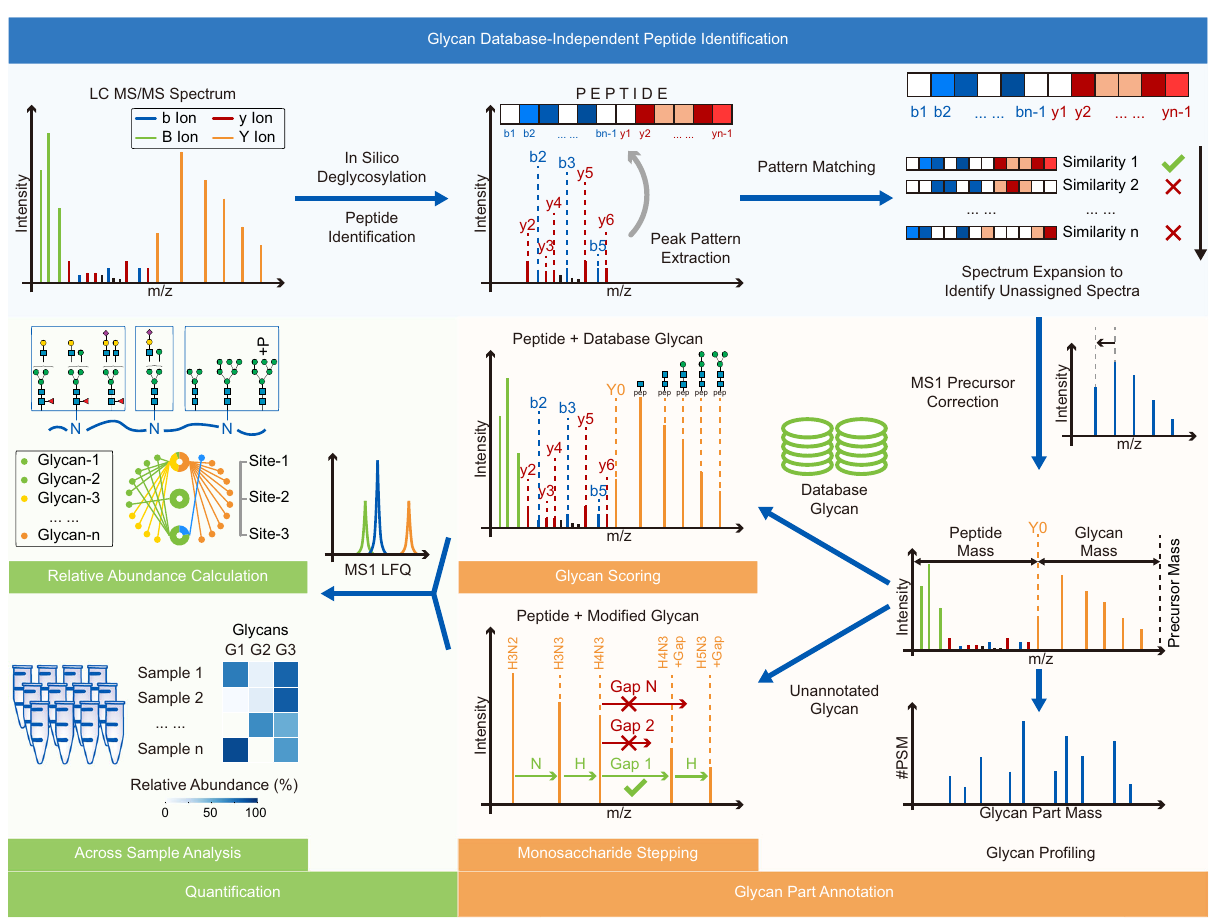
Fig. 1 Work fl ow of Glyco-Decipher. Glyco-Decipher contains three modules: (1) Glycan database-independent peptide matching. The in silico deglycosylated spectra are searched against the protein database without setting any glycans as modi fi cations, which determines the peptide backbone for glycopeptide spectra with rich peptide fragment ions. Then, the fragmentation patterns of the peptide backbones are extracted and utilized to match spectra that remain unannotated. This step, termed “ spectrum expansion ” , enables the identi fi cation of peptide backbones of glycopeptide spectra with poor peptide fragmentation. (2) Glycan annotation. The mass of the glycan part is precisely derived by the mass difference between the precursor and the peptide backbone. The mass pro fi le of glycans in a system is constructed without the use of glycan databases. For glycan annotation, the experimental B/Y ions in glycopeptide spectra are fi rst matched to their theoretical fragment ions of database glycans to identify glycans. For glycans that do not match any database entries, Glyco-Decipher performs monosaccharide stepping to reveal the composition of modi fi ed glycans and potential modi fi cation moiety on them. (3) Quanti fi cation. The quanti fi cation module based on the elution pro fi les of glycopeptides is embedded in Glyco-Decipher and allows the computation of the abundance distributions of site-speci fi c